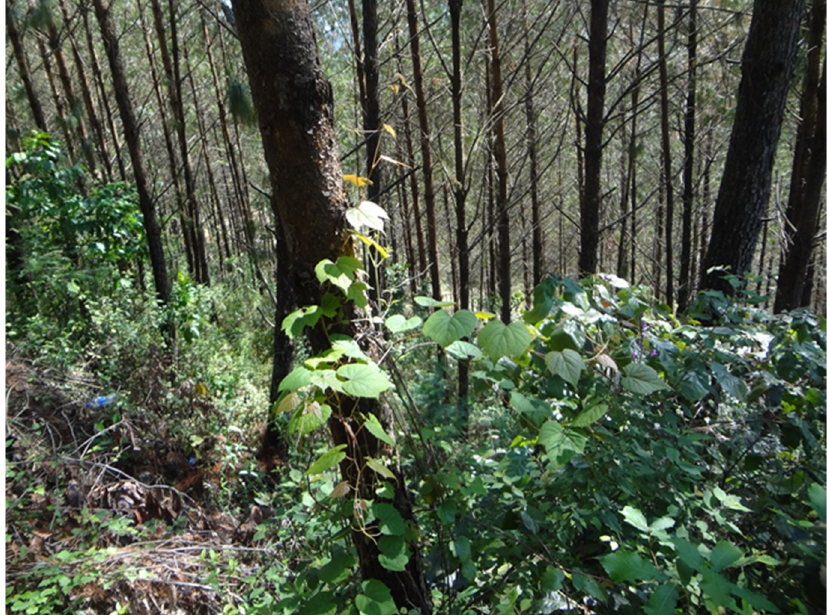
Figure 3. V. tiliifolia collected in localities of Atlahuilco, Veracruz, México.